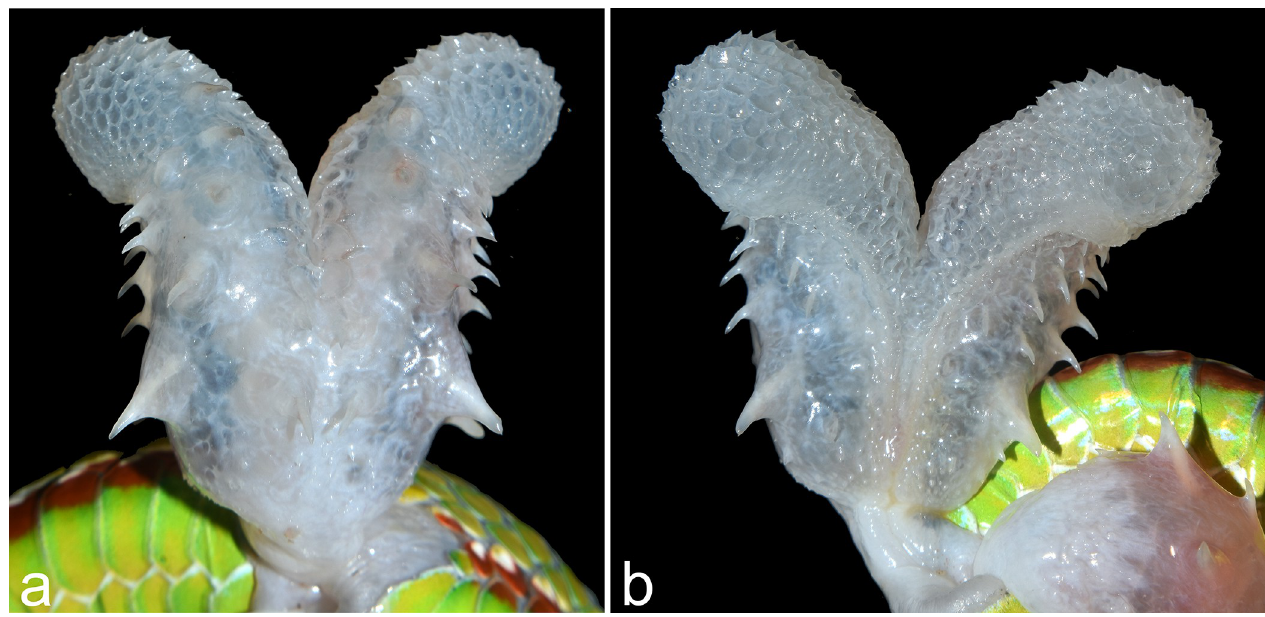
Fig 4. Hemipenis of paratype male BNHS 3658, (a) asulcal view, (b) sulcal view.